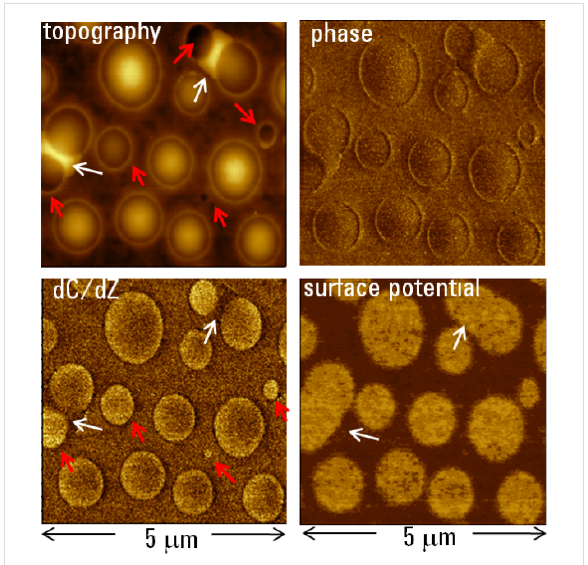
Figure 9: Topography, phase, surface potential and d C /d Z images of an 80 nm thick film of PVAC/PS blend on ITO glass. The contrast covers height corrugations in the 0–45 nm range, phase changes in the 0–45 degrees range, surface potential variations in 0–0.4 V range and d C /d Z alternations in the 0–80 mV